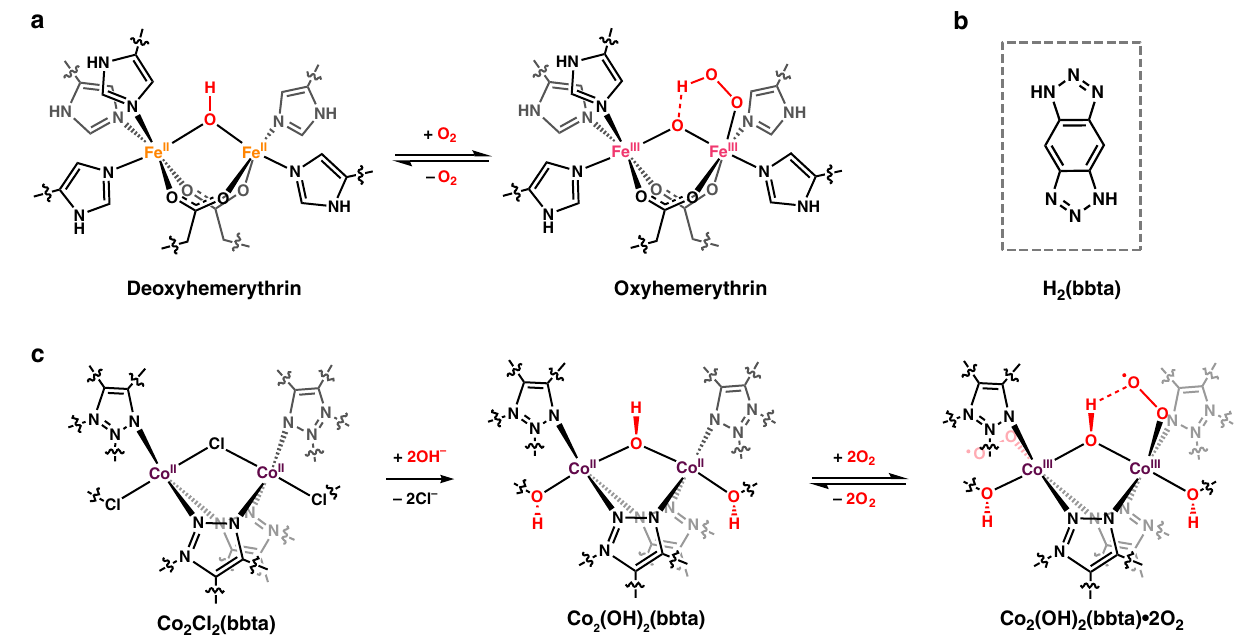
Fig. 2 Hydrogen bond stabilization of dioxygen binding in hemerythrin. a Illustration of O 2 binding in the metalloprotein hemerythrin, which shows the critical role that the bridging hydroxo group of the active site plays in the stabilization of the resulting iron(III)-hydroperoxo species. b The structure of the H 2 bbta ligand, 1 H ,5 H -benzo(1,2- d: 4,5- d ′ )bistriazole), used in this work. c Illustration of post-synthetic modi fi cation of Co 2 Cl 2 (bbta) by anion exchange with OH − (left) to form Co 2 (OH) 2 (bbta) (middle) 33 . The bridging hydroxo groups in this structure provide stabilization to bound O 2 (right) in a manner analogous to oxyhemerythrin.